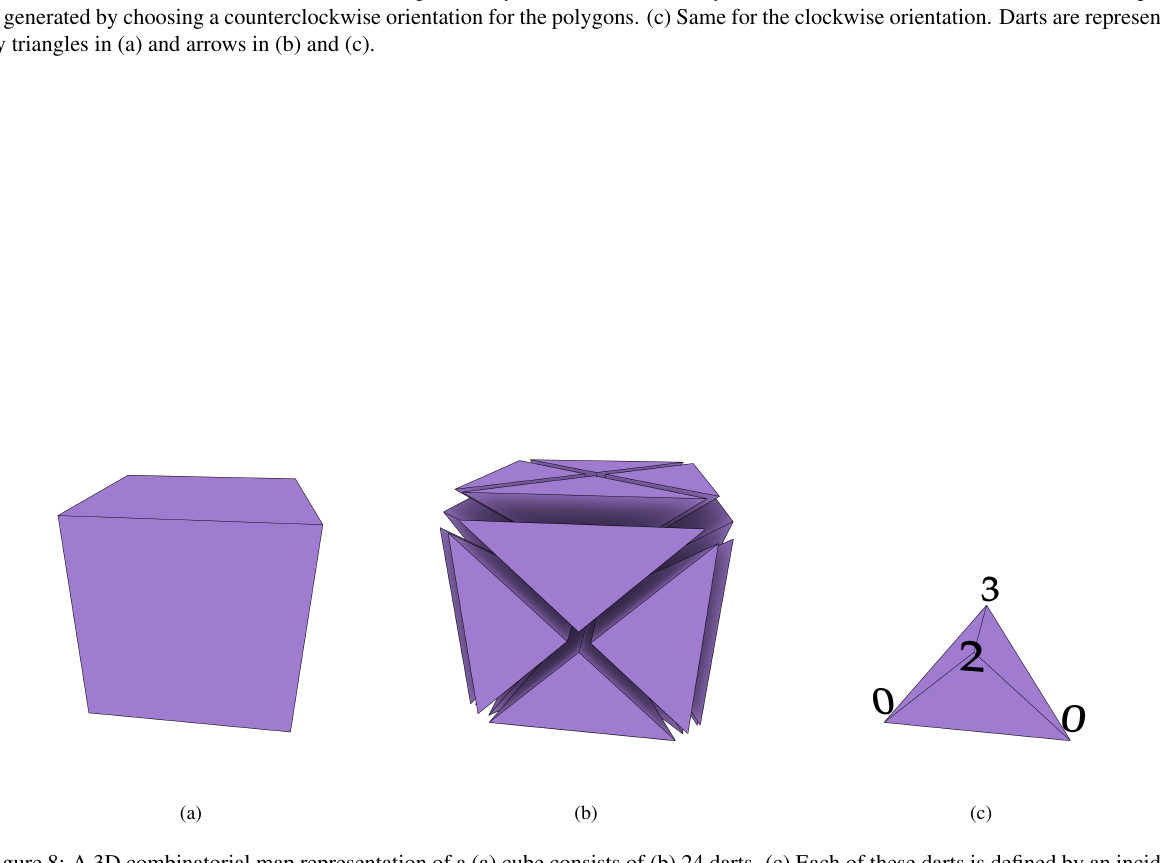
Figure 8: A 3D combinatorial map representation of a (a) cube consists of (b) 24 darts. (c) Each of these darts is defined by an incident edge-face-volume triplet. In this case, they are the lower front edge (between the 0s), front face (2) and the only volume of the